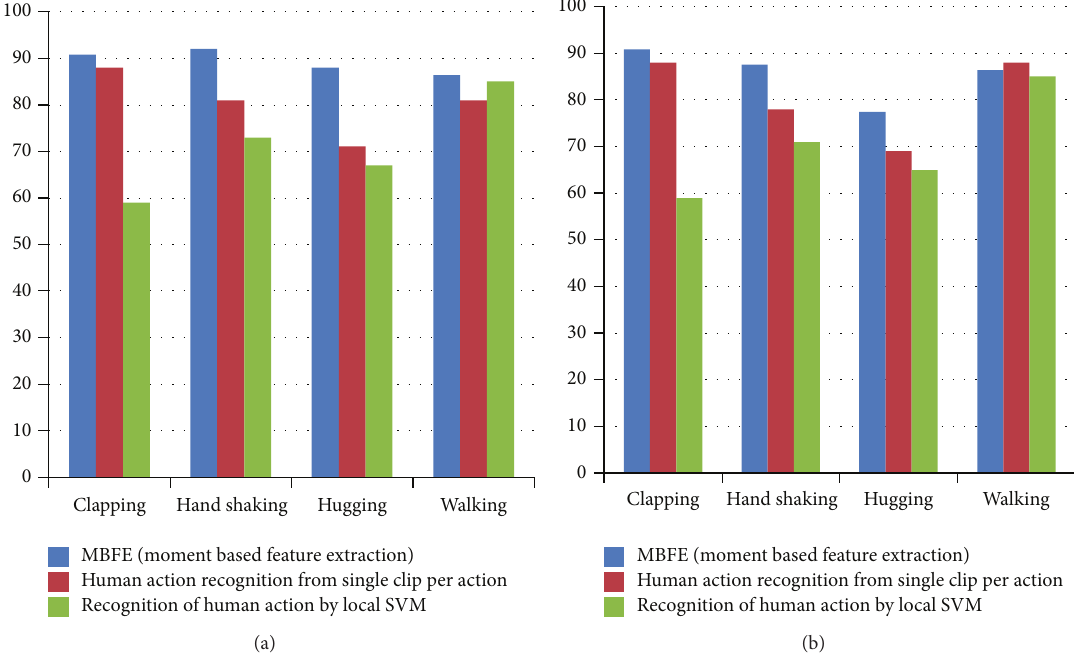
Figure 8: (a) The comparison of results using only the medial frames. (b) The comparison using all of the frames.